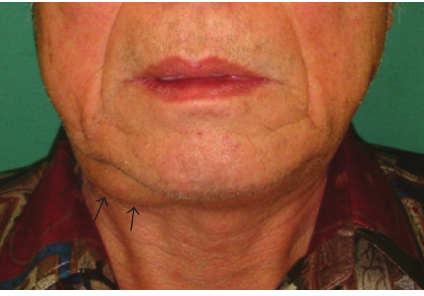
Figure 3: Surgical specimen. The mass was cystic, measured 4.0 × 3.0 × 2.5 cm, and had a smooth surface.